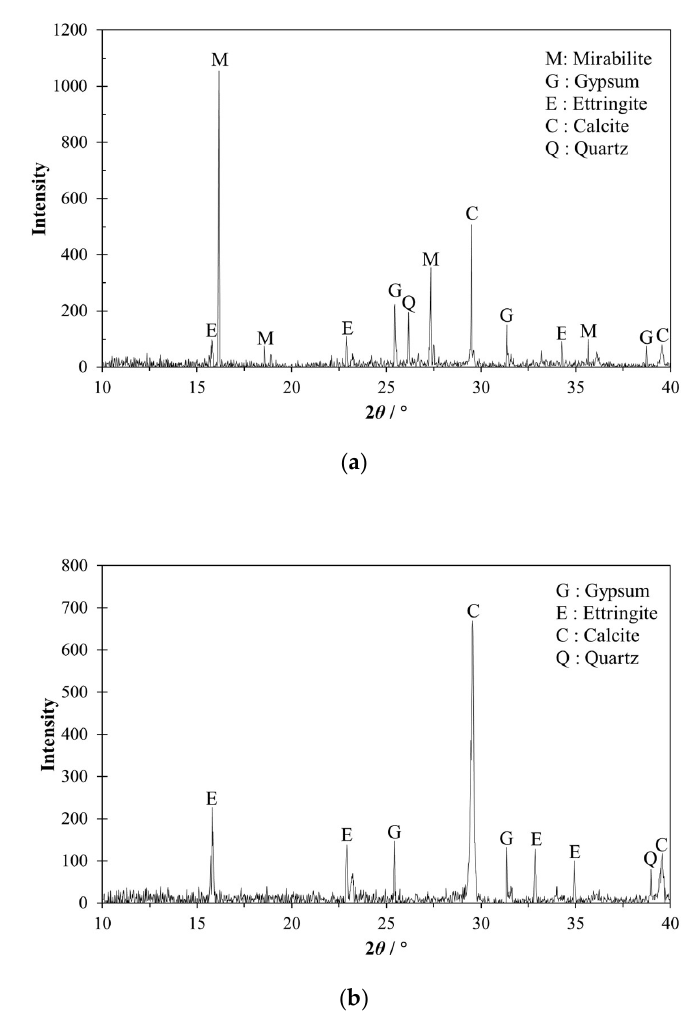
Figure 10. XRD patterns of specimens under different exposure conditions for 90 d: ( a ) Group B undergoing sulfate attack; ( b ) group C cured in distilled water.